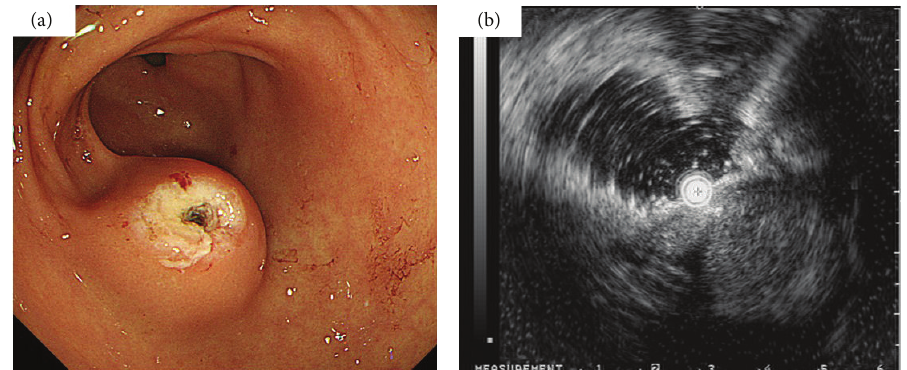
Figure 1: Upper gastrointestinal endoscopy and endoscopic ultrasonography findings. The image shows a well-circumscribed elevated mass, measuring 30 × 30 mm, with normal overlying mucosa in the anterior wall of the gastric antrum (a). The image shows a well-demarcated mass in the third and fourth layers of the gastric wall with a hypoechoic pattern (b).